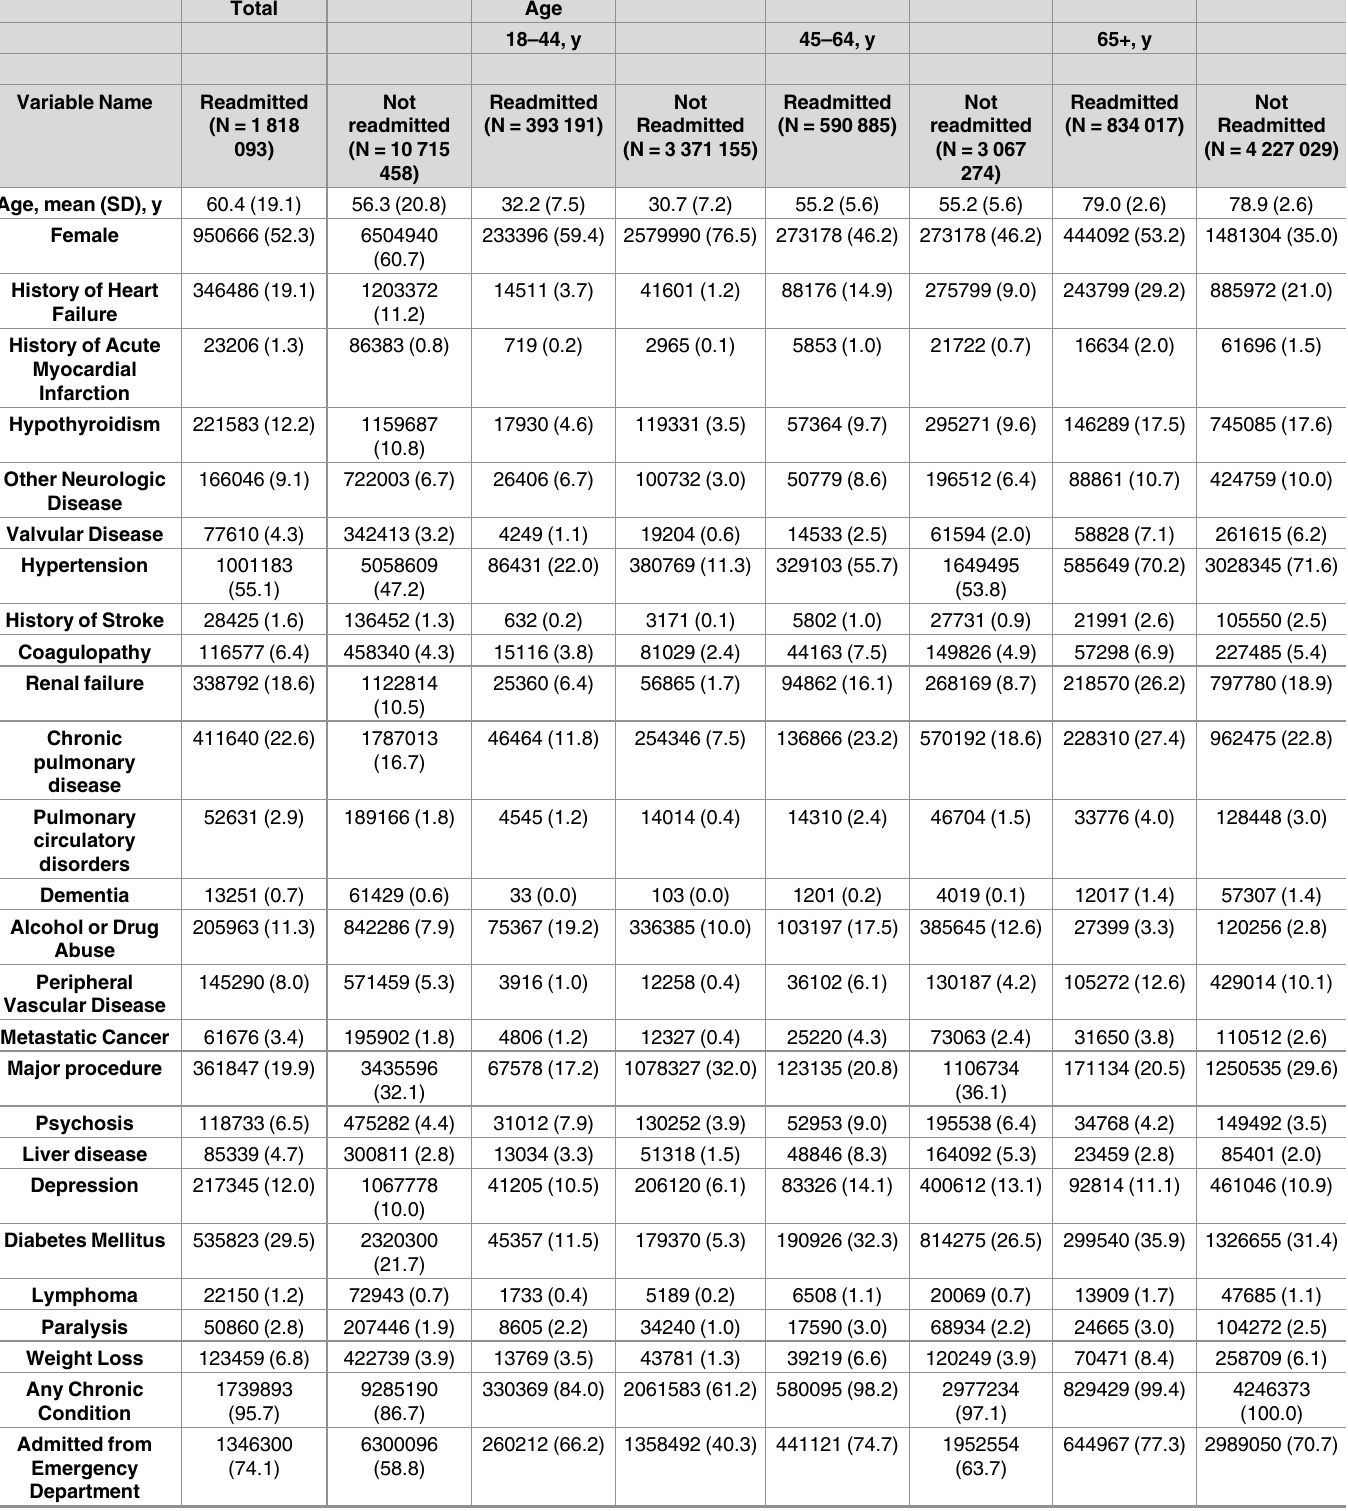
Table 1. Baseline characteristics among readmitted and non-readmitted patients by age category a